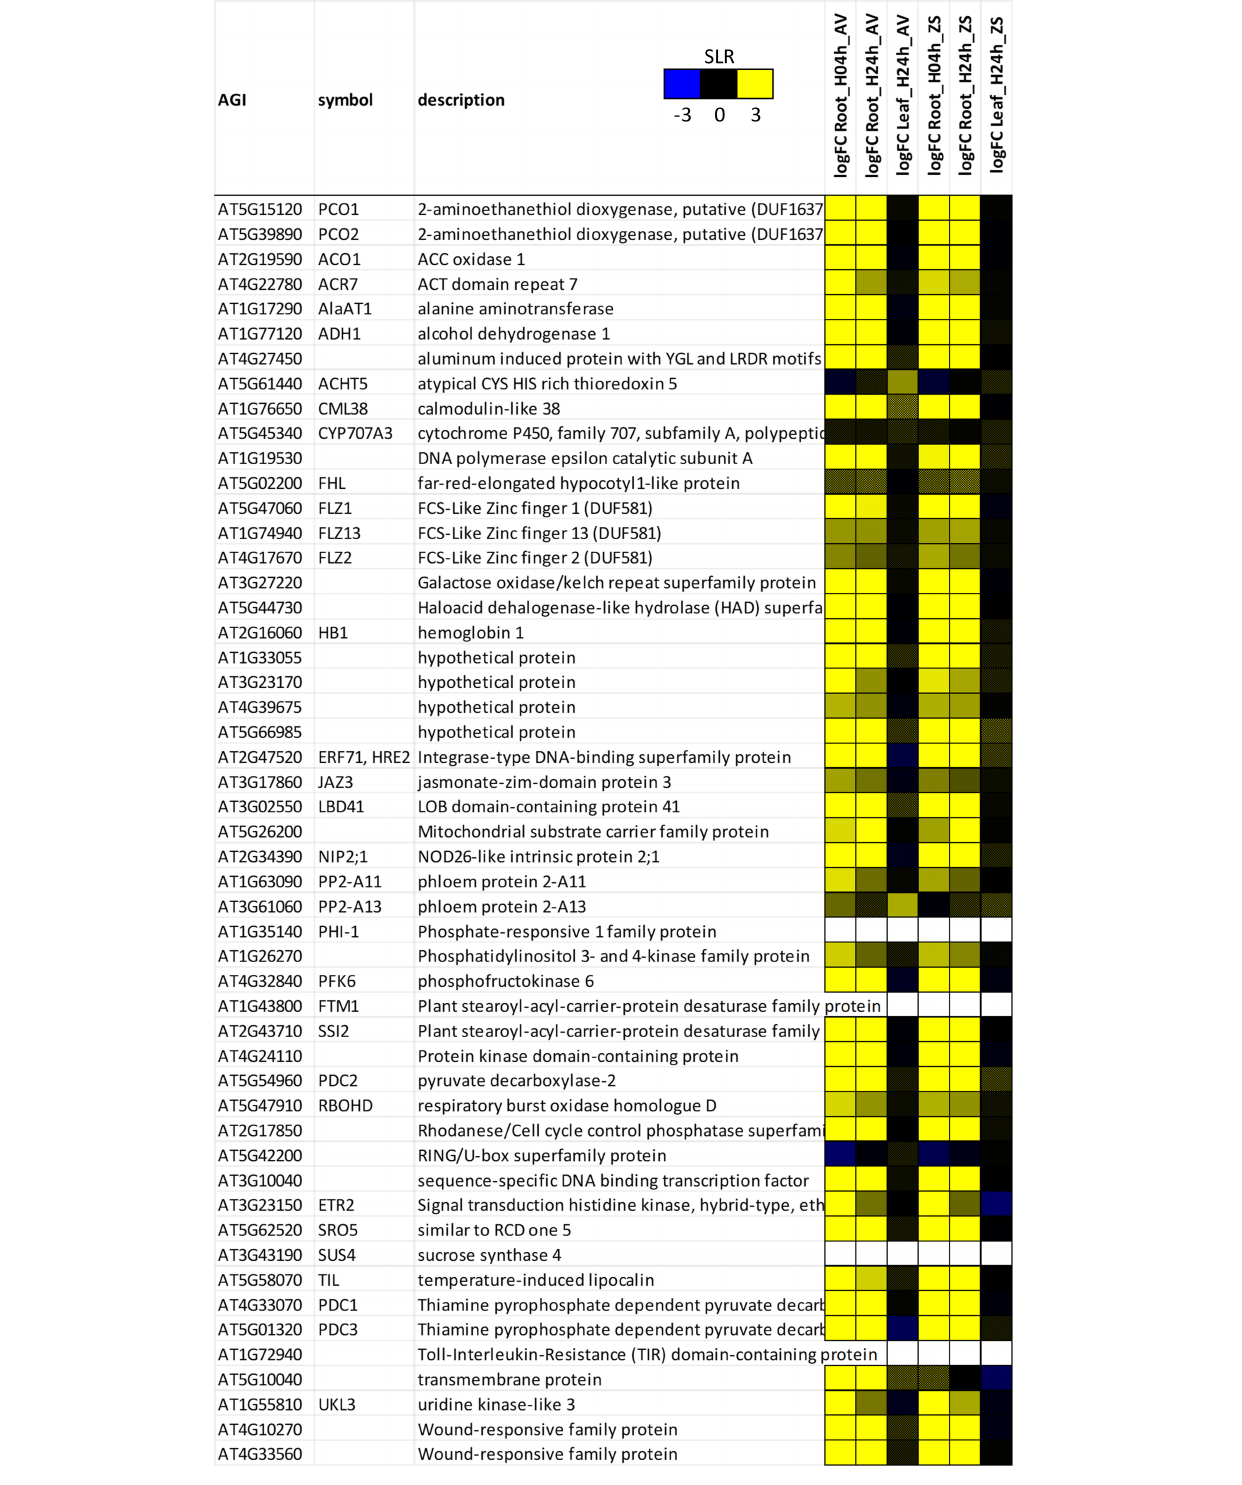
Frontiers in Plant Science |